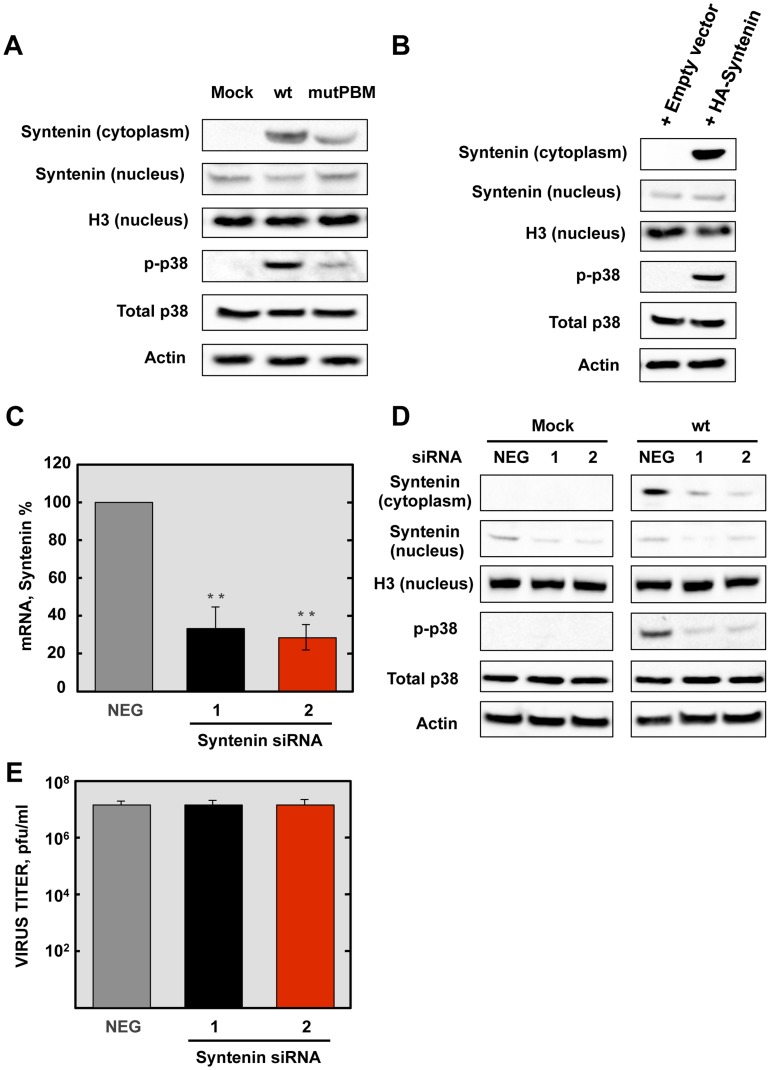
Role of syntenin in the E protein PBM-dependent p38 MAPK activation.(A) Vero E6 cells were mock-infected or infected with recombinant viruses containing (wt) or lacking (mutPBM) E protein PBM, and the presence of syntenin in the cytoplasm and nucleus and active p38 MAPK (p-p38) were detected by Western blot analysis at 24 hpi. As controls, histone H3 (H3), total p38 MAPK (Total p38) and actin were analyzed. (B) Vero E6 cells were transfected with an empty plasmid (empty vector) or a plasmid encoding a HA-tagged syntenin (HA-syntenin), and the presence of syntenin in the cytoplasm and nucleus, and active p38 MAPK were detected by Western blot analysis at 24 hpt. As controls, histone H3, total p38 MAPK, and actin were analyzed. (C) Quantification by qRT-PCR of syntenin mRNA in cells transfected with syntenin-specific siRNA (1 and 2) compared to reference levels from cells transfected with a validated-negative control siRNA (NEG). Mean values are reported, and statistically significant data are indicated with two (P<0.01) asterisks. (D) Effect of silencing syntenin expression on Vero E6 cells, mock-infected or infected with the wt virus. The presence of syntenin in the cytoplasm and nucleus and active p38 MAPK were detected by Western blot at 24 hpi. As controls, histone H3, total p38 MAPK and actin were analyzed. (E) Viral titers of wt virus in syntenin silenced Vero E6 cells were determined at 24 hpi. The experiments were performed three times, and the data represent the averages of triplicates. Standard deviations are indicated as error bars.